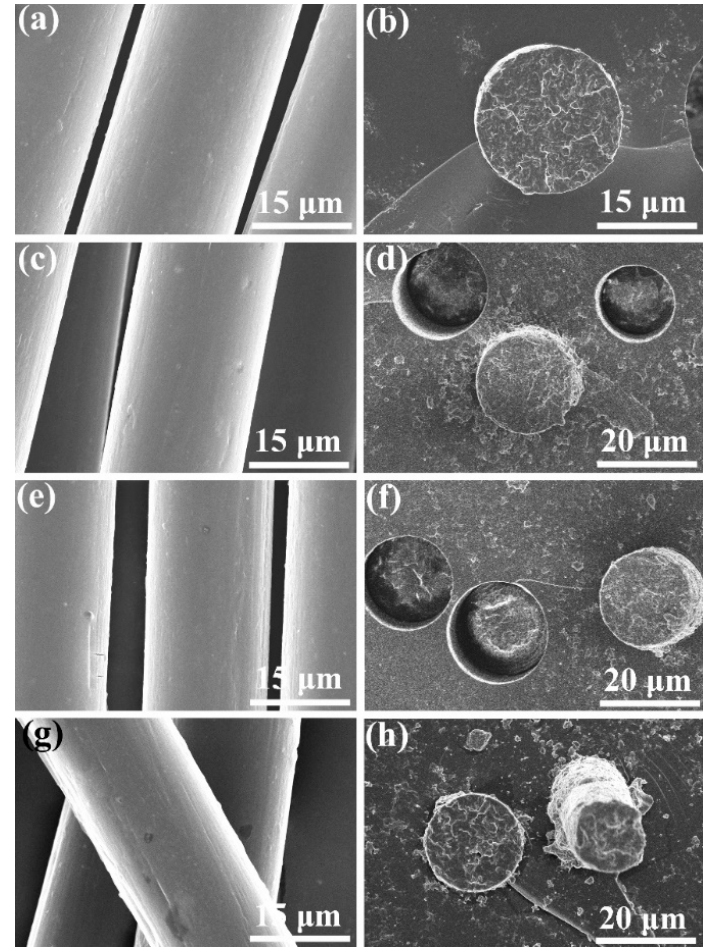
Figure 6. SEM micrographs of profiles (left) and transverse surfaces (right) of ( a , b ) pure POM fiber and POM / PLLA bicomponent fibers containing ( c , d ) 5, ( e , f ) 10, and ( g , h ) 20 wt % PLLA at the ultimate draw ratios.